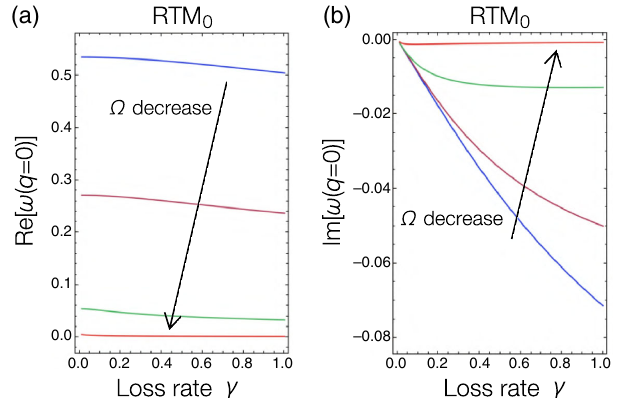
FIG. 7. (a) Real and (b) imaginary parts of the complex eigenvalues for the most softened mode (i.e., RTM 0 mode) at q ¼ 0 in the presence of nonzero cavity-loss rate γ . From top to bottom (respectively, bottom to top) curves in (a) [respectively, (b)], the bare phonon frequency Ω is set to be 1, 0.5, 0.1, and 5 , and g ¼ 3 . 5 0.01. The parameters are d ¼ 1 , ω p ¼